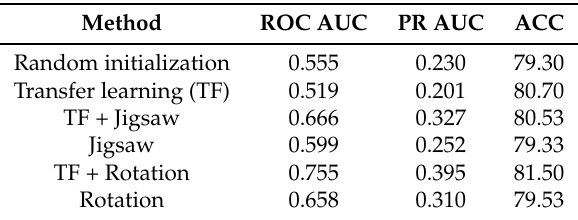
Table 3. Training on 20 images (1% of the training set).